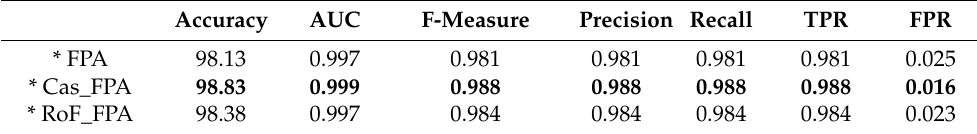
Table 11. Detection performances of FPA, Cas_FPA, and RoF_FPA on the Drebin